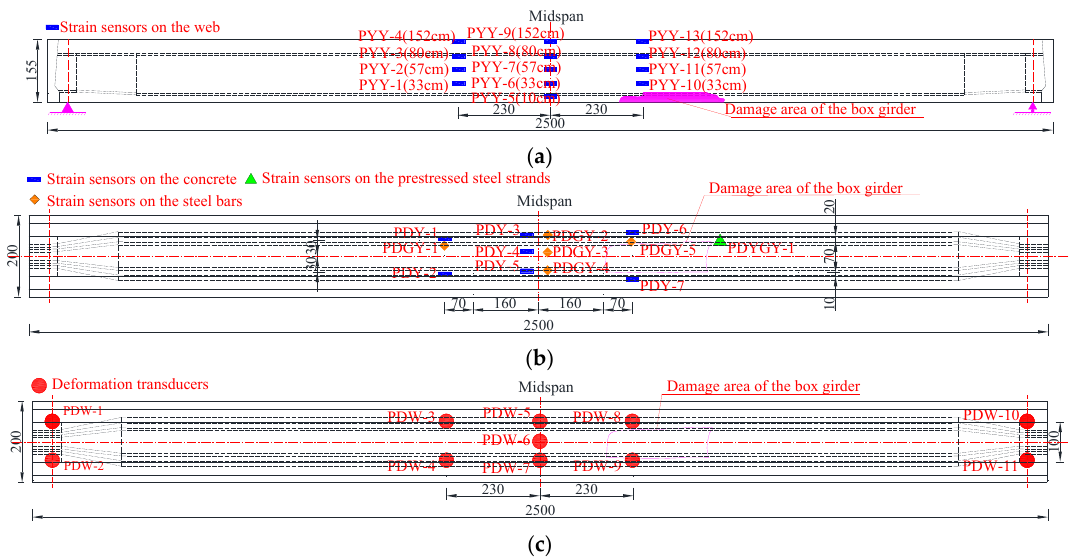
Figure 15. Sensor arrangement for the loading test of the damaged box girder (Unit: cm). ( a ) Strain sensors arranged on the web; ( b ) Strain sensors layout diagram of bottom plate; ( c ) Deformation sensors layout diagram of bottom plate.